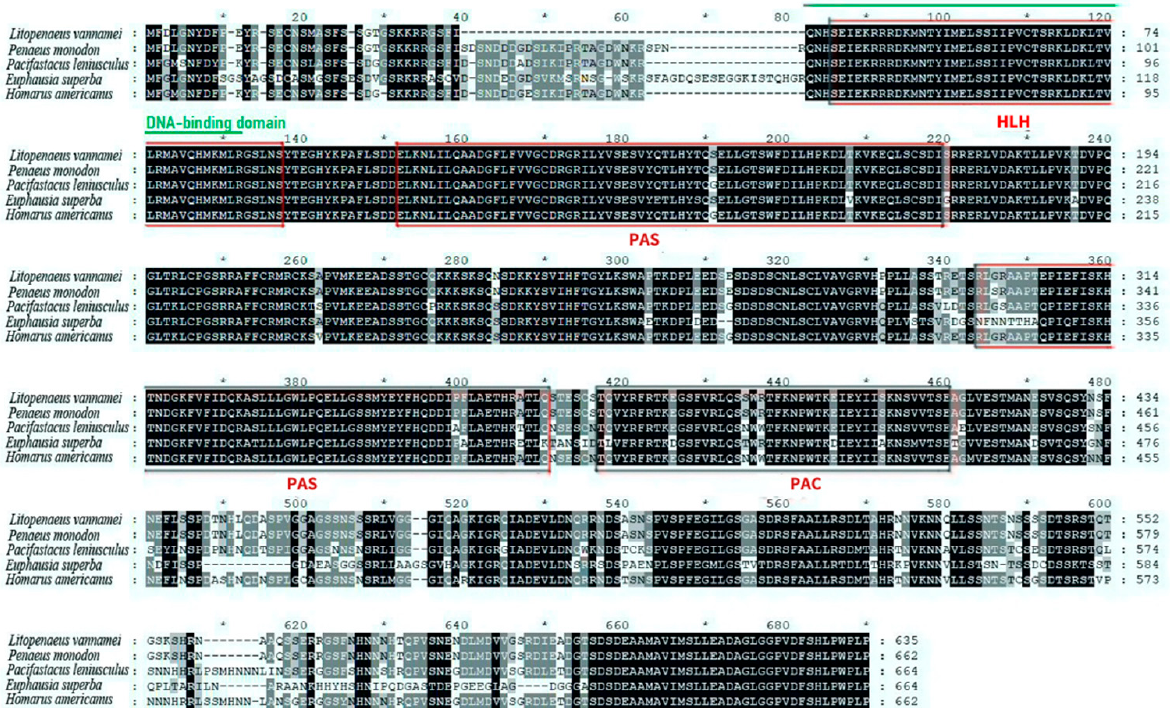
Figure 2. Alignment of the sequences of BMAL1. The consensus residues are in black, the conserved domains and motifs are indicated in red, and DNA-binding domains are indicted in green. The genBank accession numbers of the aligned sequences are as follows: L. vannamei , ROT67541.1; Pa. leniusculus , AFV39705.1; E. superba , ANW48377.1; H. americanus